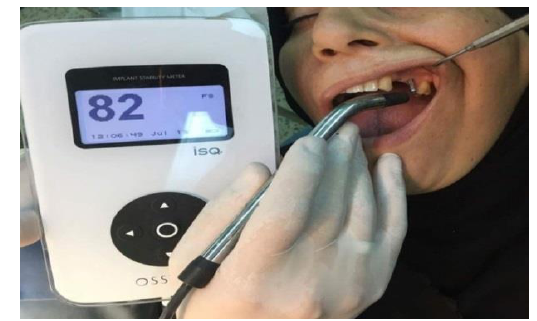
Figure (5): Secondary implants stability measurement by osstell